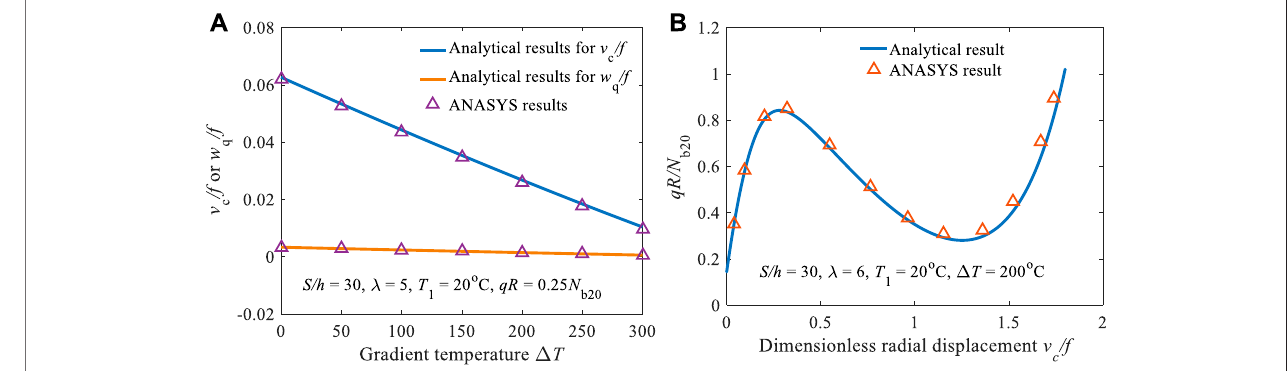
Frontiers in Materials |